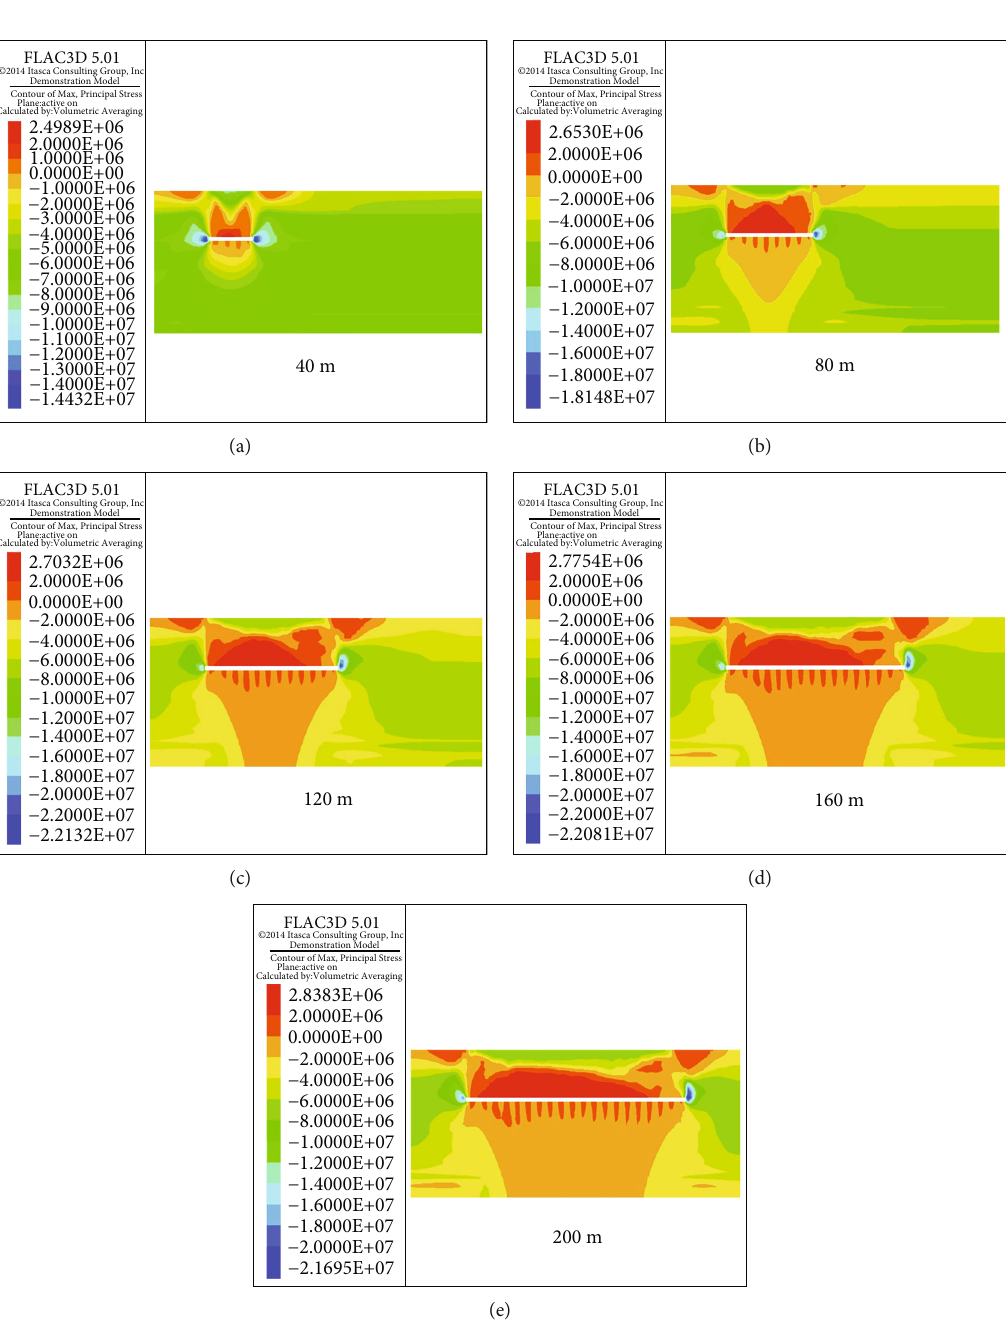
Figure 6: Cloud chart of maximum principal stress distribution at di ff erent propulsion distances (unit: